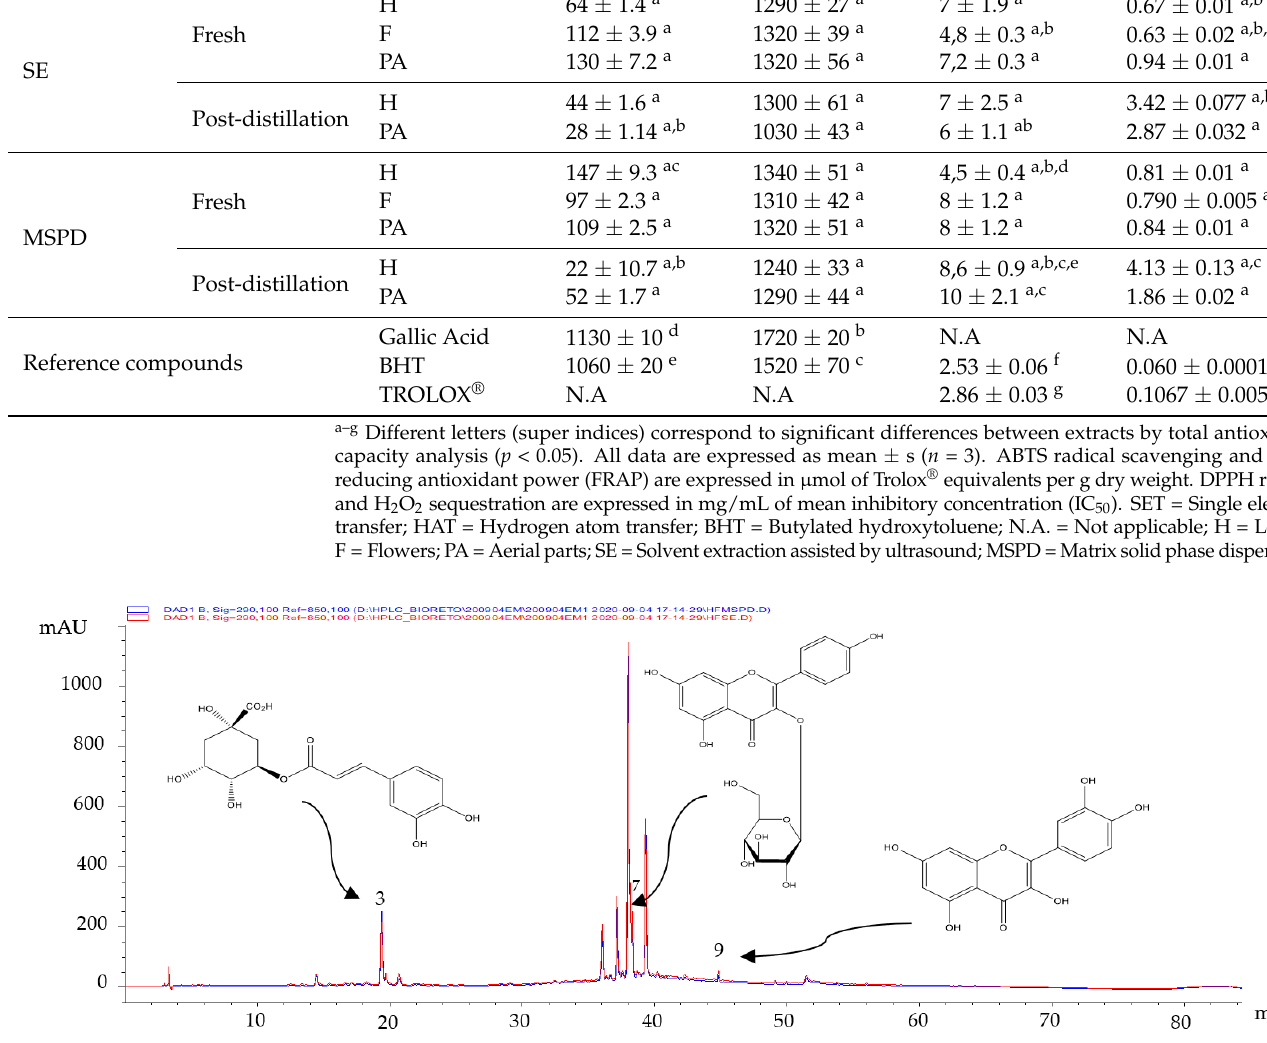
Figure 1. Chromatographic profiles obtained by HPLC-DAD of the fresh leaves’ MSPD extracts.